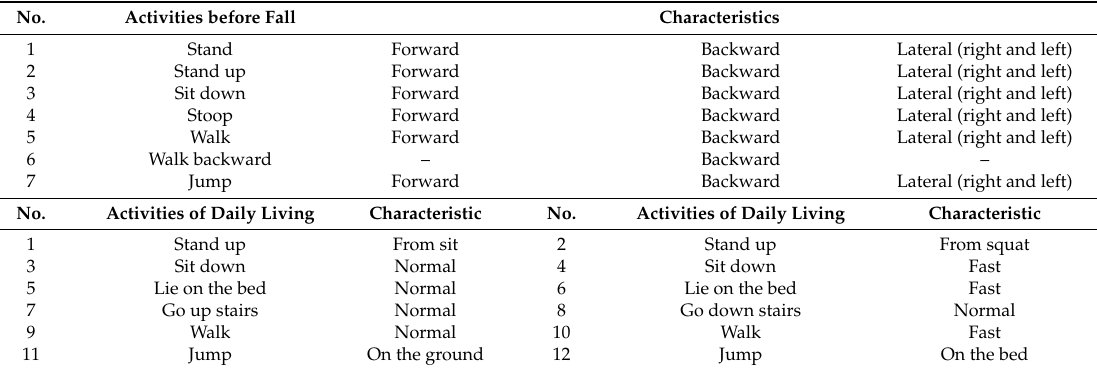
Table 2. The types and characteristics of falls and ADLs for